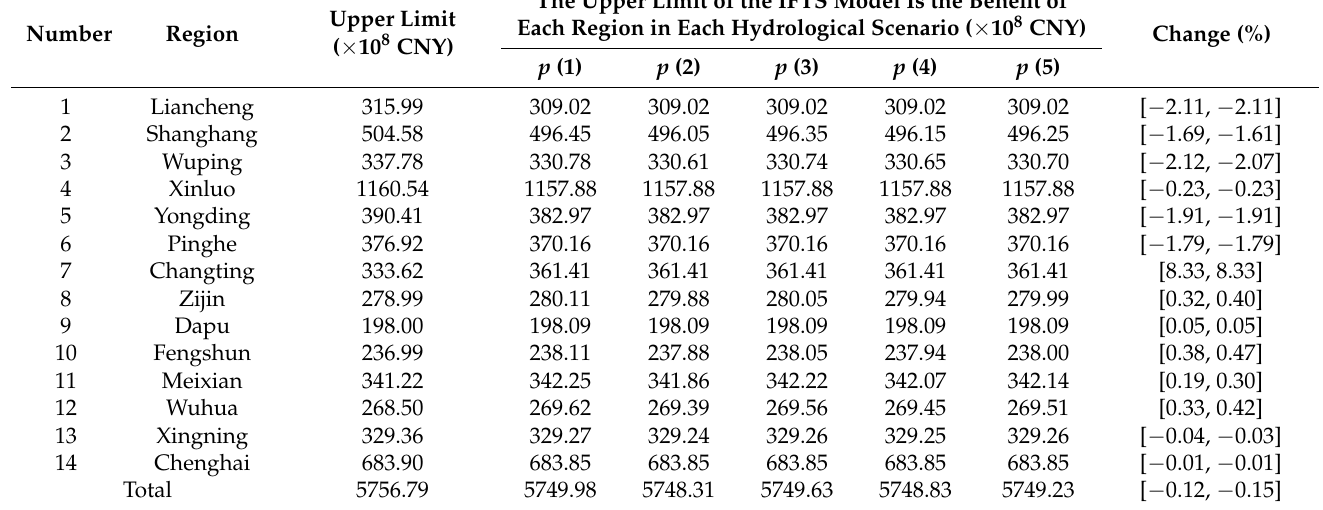
Table 4. Economic benefits of each administrative unit simulated by the IFTS model under different hydrological scenarios (upper